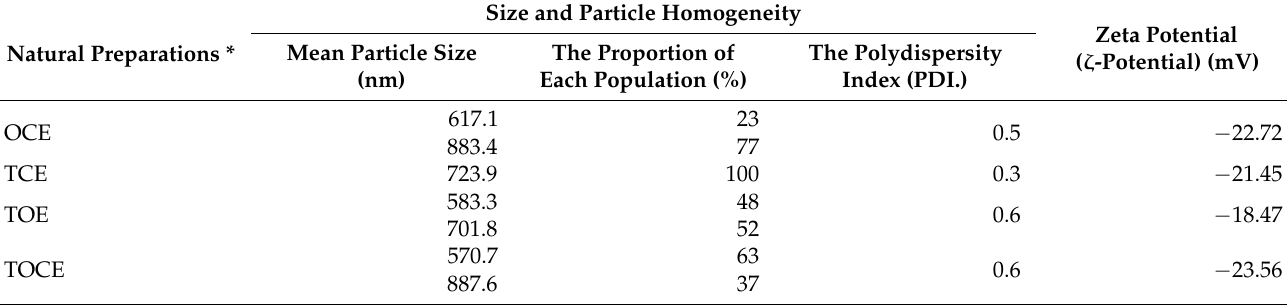
Table 3. Mean particle size (nm), polydispersity index (PDI), and zeta potential ( ζ -Potential) (mV) of natural